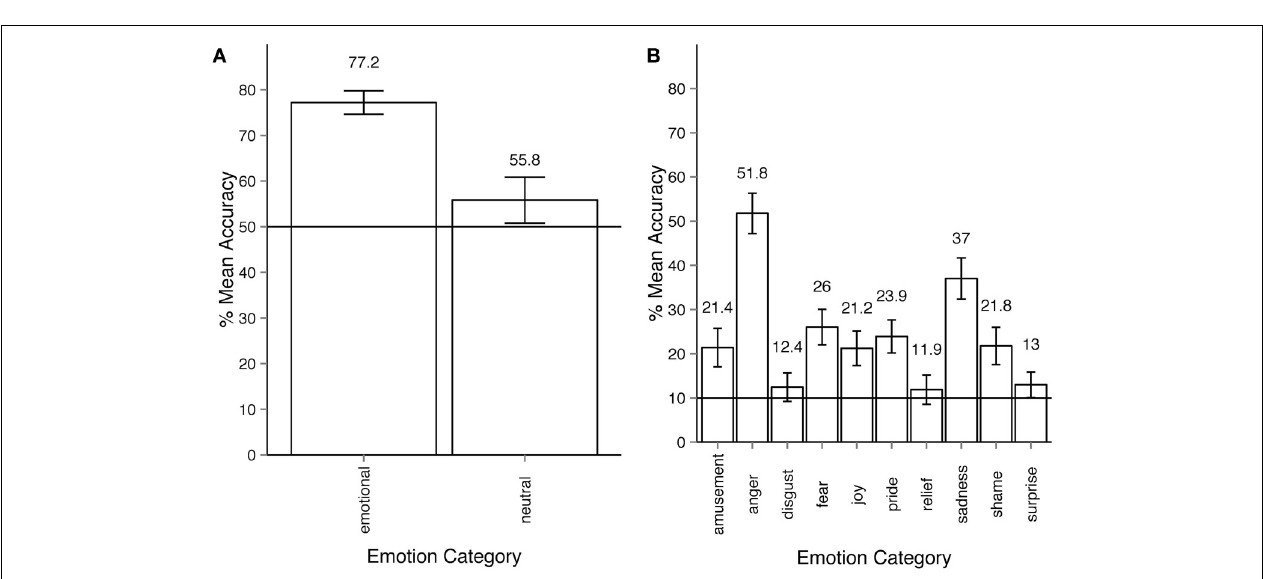
choosing either neutral or emotional category, then, if the emotional option was chosen, select the oppropriate emotion category of out ten non-neutral categories available. Each motion sequence was shown three times after which the participant had unlimited time to respond. The participant could always alter their choice before proceeding to the next trial.